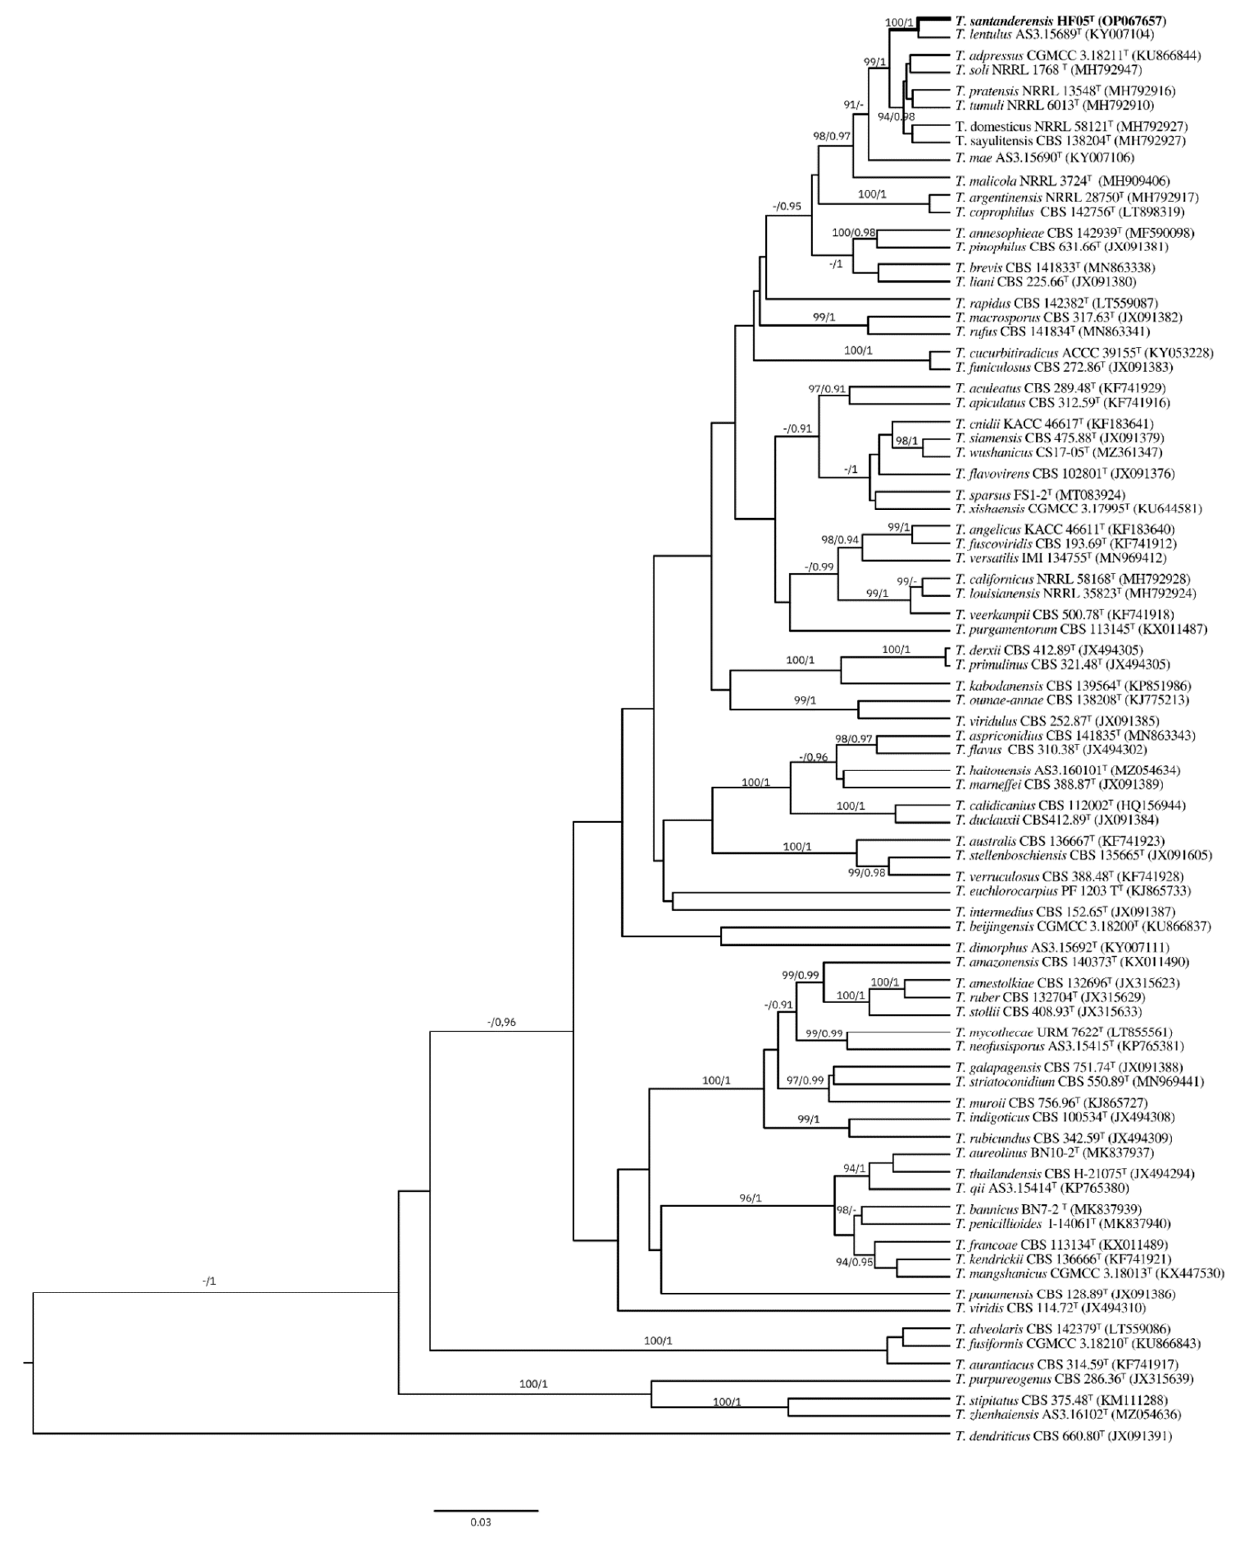
Figure 5. Individual phylogeny of BenA . BI phylogram inferred from partial BenA sequences. Ultrafast-bootstrap percentages over 90% derived from 10,000 replicates and posterior probabilities over 0.9 of posterior support are indicated at the nodes. T indicates ex-type strains, strains belonging to new species are indicated in boldface. Scale Bars: number of substitutions per nucleotide